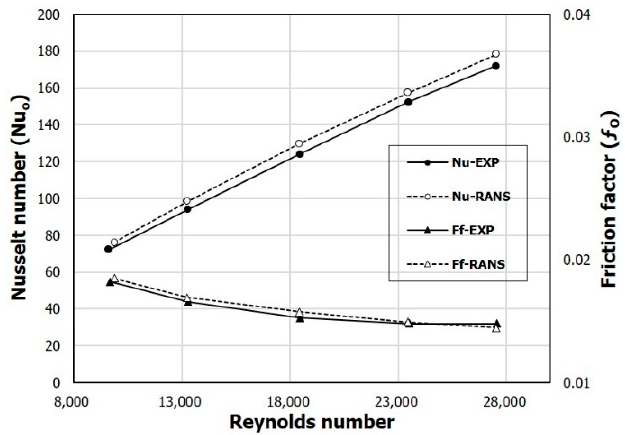
Figure 4. Validation of numerical results for a solar air heater (SAH) with triangular ribs using experimental data of Bekele et al. [8].